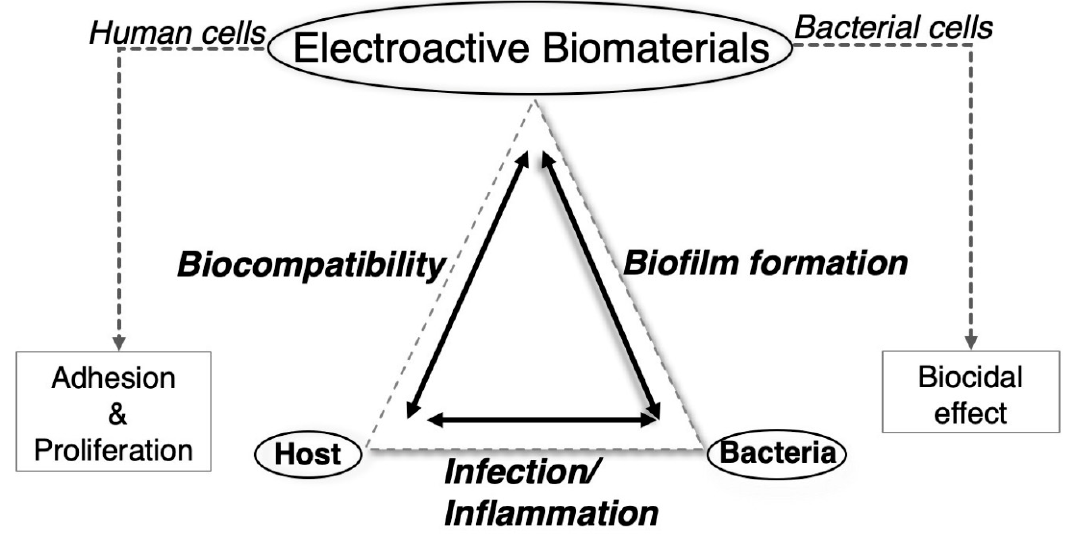
Figure 1. Relationship between electroactive biomaterials and human and bacterial cells in the context of tissue engineering.